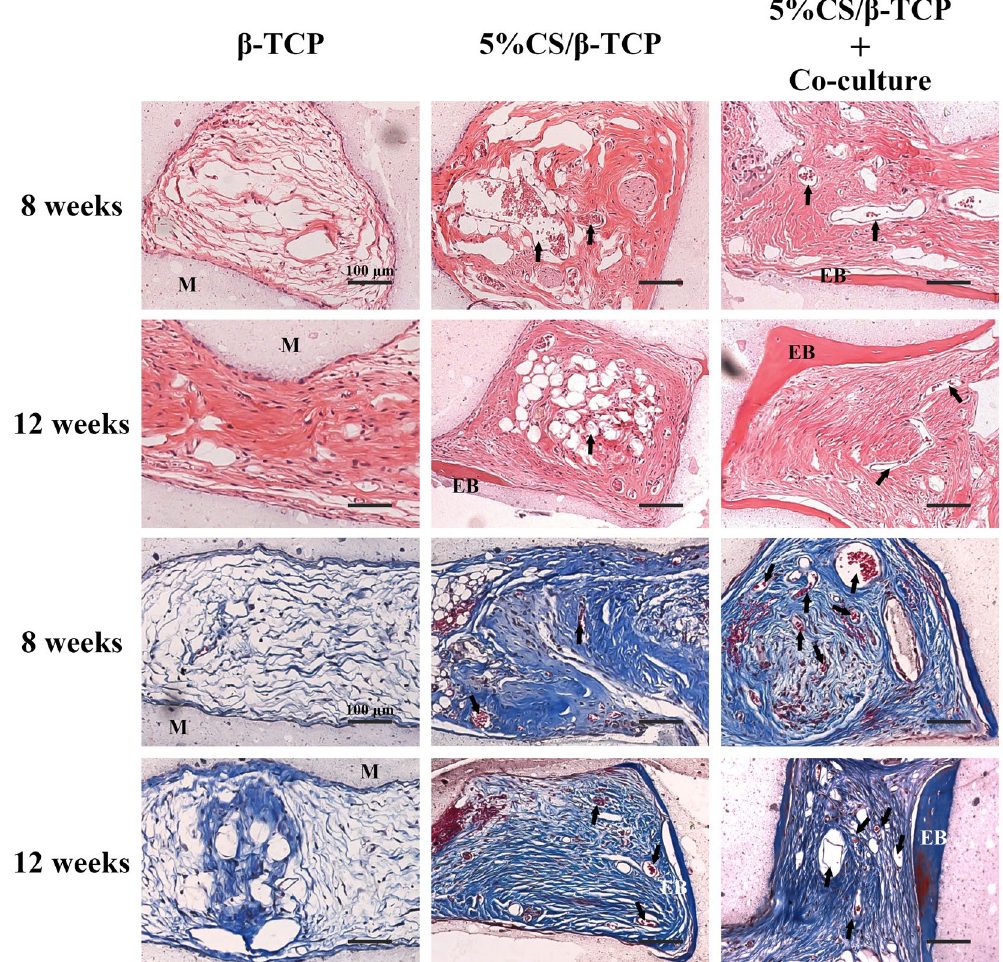
Figure 8. Histological observation of vessel penetration and ectopic bone formation on β -TCP and 5%CS/ β - TCP scaffolds, as well as on 5%CS/ β -TCP scaffolds pre-seeded with HUVECs and hBMSCs. Specimens